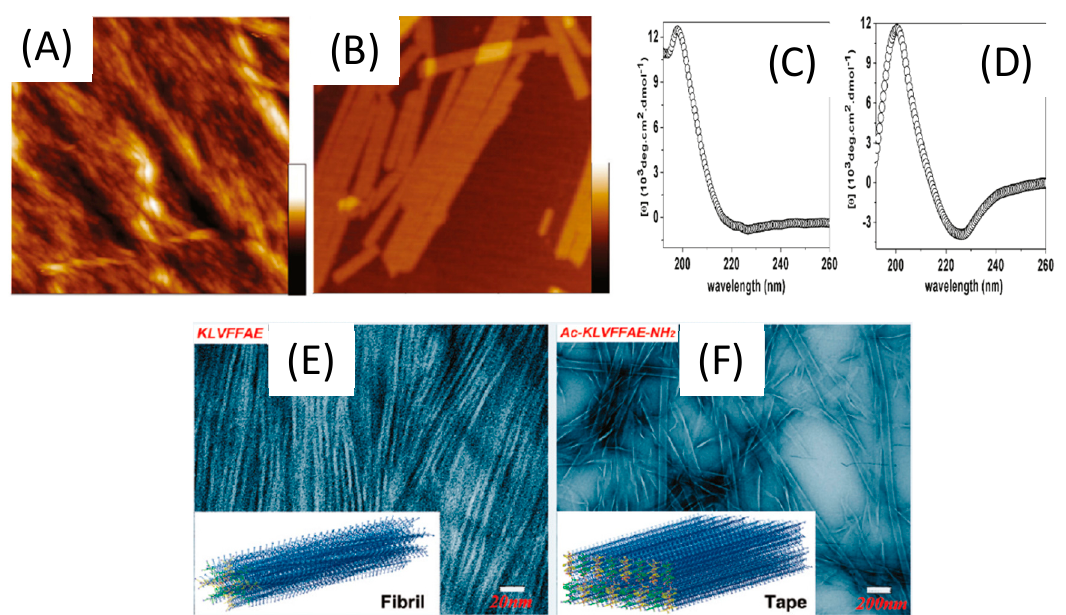
Figure 7. Characterization of short β -amyloid (A β ) peptides (16–22) at a concentration of 3.0 mM, in acetonitrile/water (2:3, v / v ) at pH 2.0. AFM topographical images of KLVFFAE ( A ) and Ac-KLVFFAE-NH2 ( B ). All images are 1.5 × 1.5 μ m in size, and the height scales are 70 and 15 nm for ( A ) and ( B ), respectively. CD spectra of KLVFFAE ( C ) and Ac-KLVFFAE- NH 2 ( D ). TEM micrographs of aggregated structures of KLVFFAE ( E ) and Ac-KLVFFAE-NH2 ( F ), Inserts: schematic representation of a model nanofibril formed by KLVFFAE and a model nanotape formed by Ac-KLVFFAE-NH2 in these experimental conditions. Adapted with permission from Reference [122].